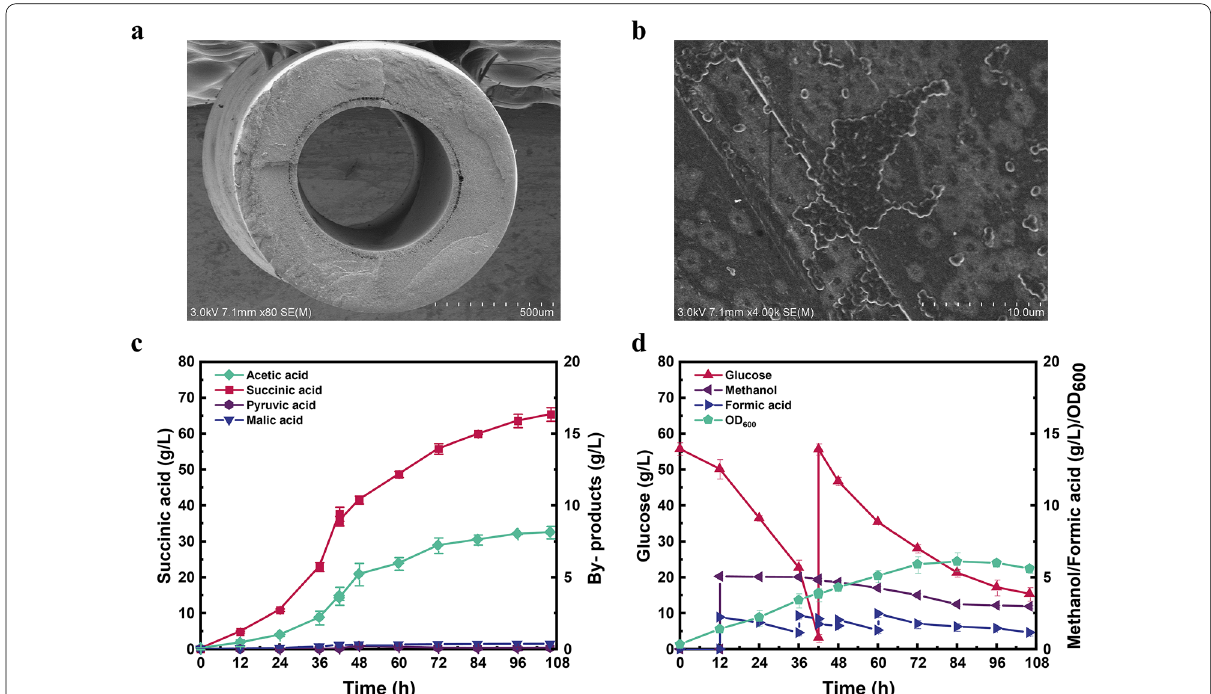
Fig. 6 Immobilize cells with hollow fiber membrane PVDF. a SEM analysis of hollow fiber membrane morphology. b E. coli adhering on glycosylated PHF membrane with a large mount cell and forming biofilm. c , d Fed-batch fermentation of strain G5 with biofilm-based cell-immobilized